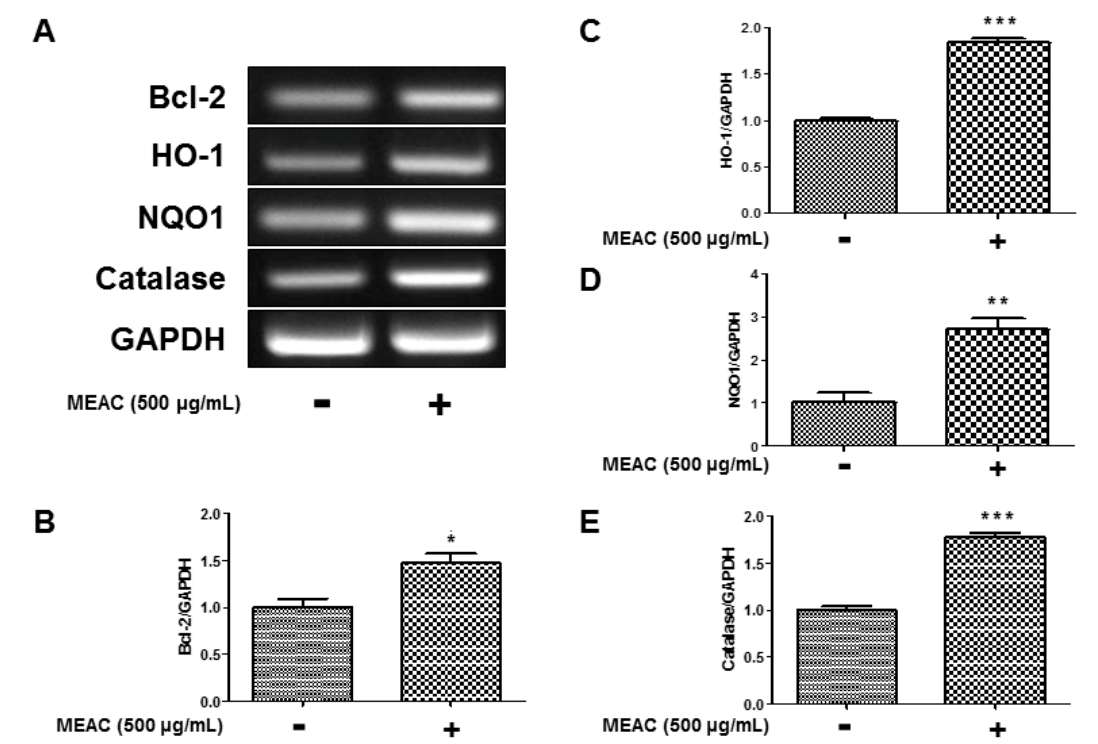
Figure 6. Effect of MEAC treatment on the expression of Bcl-2, HO-1, NQO1, and catalase at mRNA levels ( A ). The representative densitometry analyses of Bcl-2 ( B ), HO-1( C ), NQO1 ( D ), catalase ( E ) compared with GAPDH mRNA. Data are presented as the mean ± SEM. * p < 0.05, ** p < 0.01 and *** p < 0.001 versus control group ( n = 3 ).